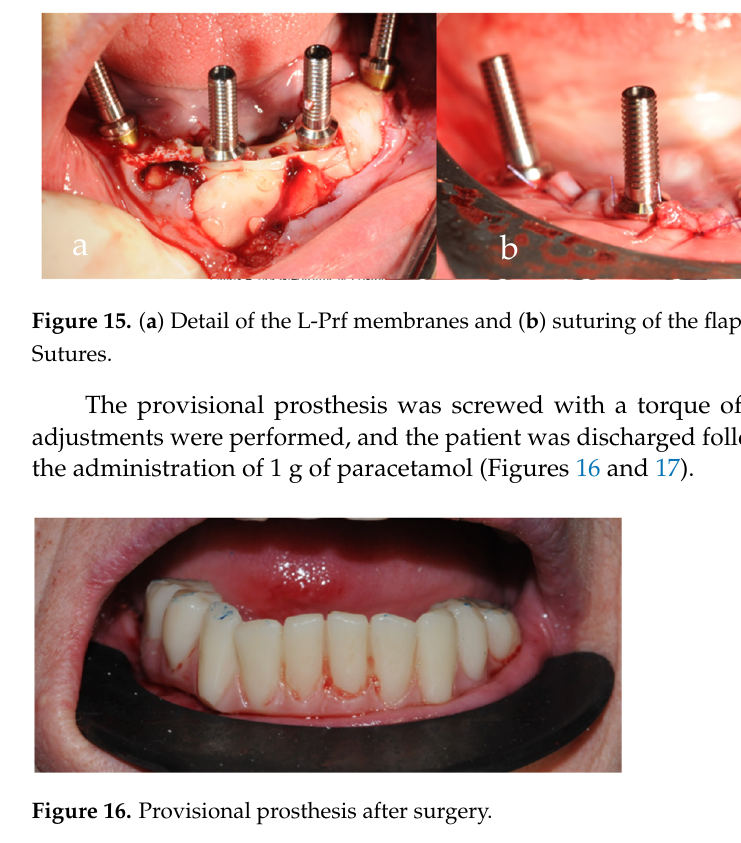
Figure 16. Provisional prosthesis after surgery.